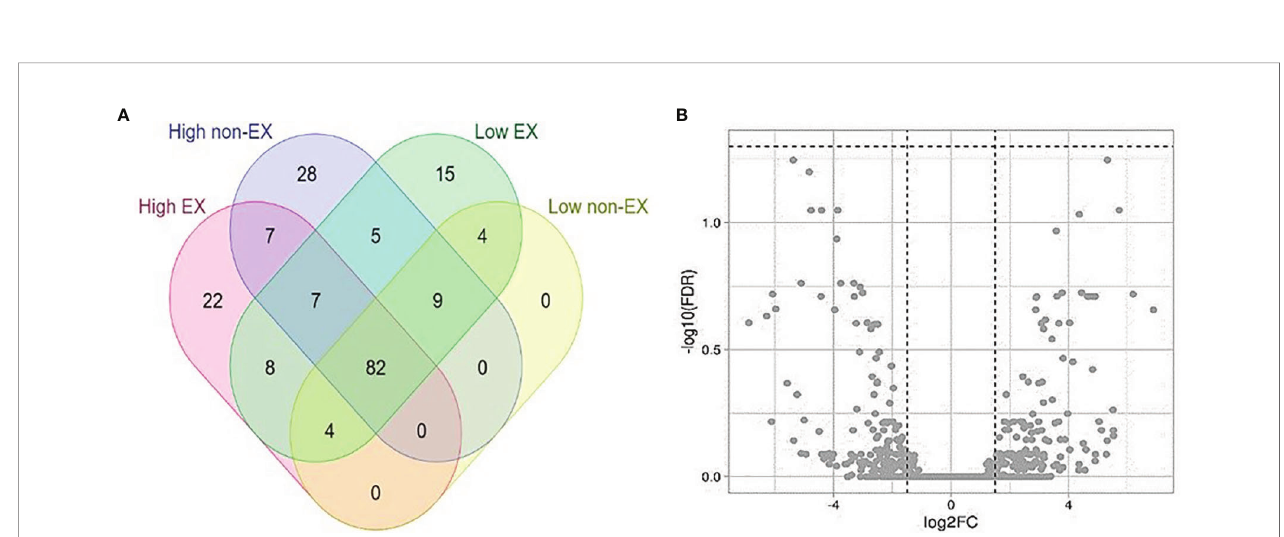
FIGURE 4 | Differential expression of top 3 DE miRNAs (A) miR-2419-3p, (B) miR-7861-3p and (C) miR-2372-5p between high tick resistance (HTR) and low tick resistance (LTR) mother EV